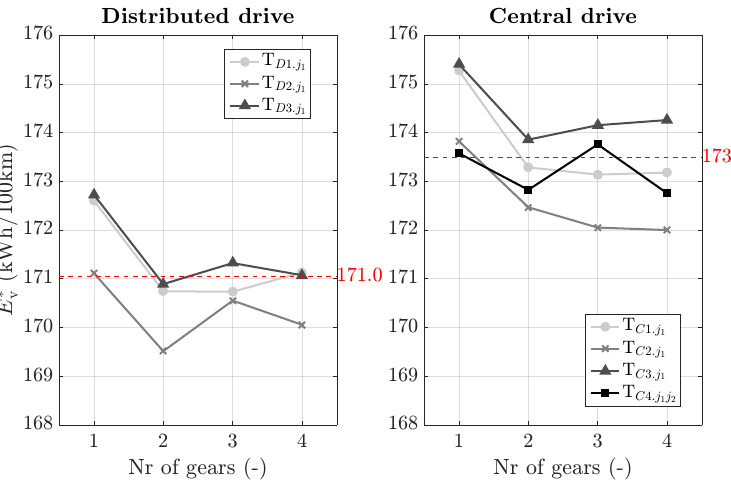
Figure 14. Plot of the optimal energy consumption E ∗ v versus the number of gears in the gearbox present for the optimization results with energy consumption as the optimization objective. The results are divided into two figures with, on the left, the distributed and, on the right, the central drive. The red line and number indicate the average energy consumption for each of the two